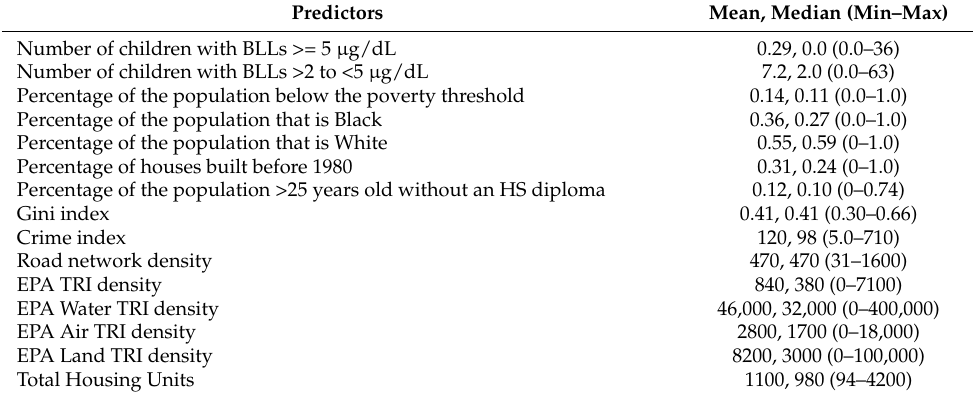
Table 2. Descriptive statistics of predictors and outcomes: 6591 raster cells in the Atlanta metro